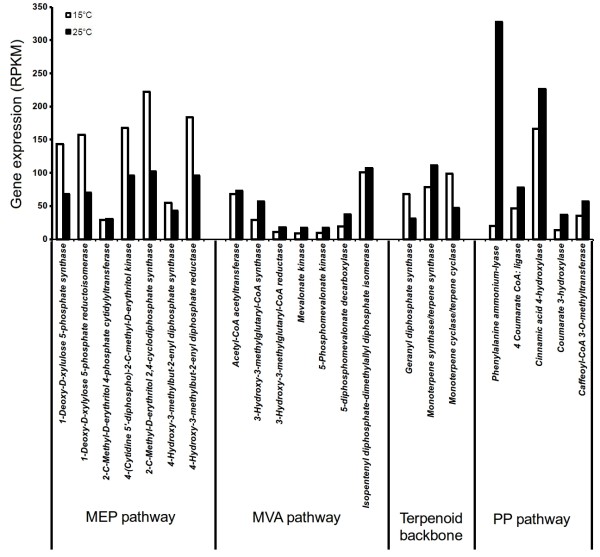
Histogram showing transcript abundance of various pathways (Figure 7 details the pathway) associated with picrosides biosynthesis at 15°C and 25°C based on reads per exon kilobase per million (RPKM) values. Mevalonate (MVA), 2-C-methyl-D-erythritol 4-phosphate (MEP) and phenylpropanoid (PP) are central pathways for picrosides biosynthesis.